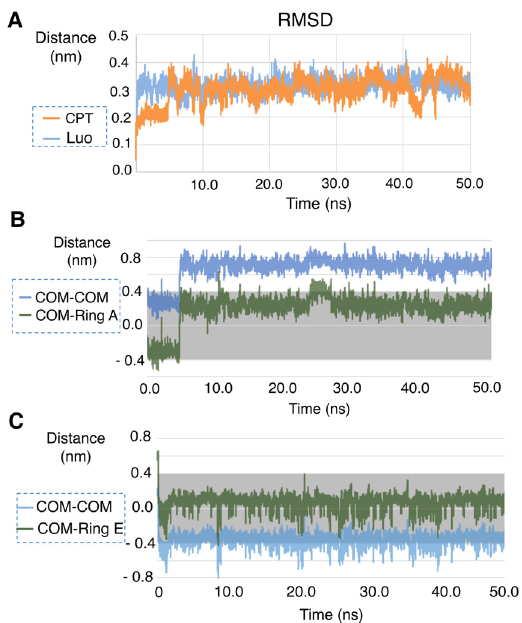
Figure 5. Molecular dynamics studies: ( A ) RMSD for the camptothecin- β -CD and luotonin A- β -CD complexes; ( B ) evolution of the distance between the center of mass (COM) of β -CD and the center of mass of camptothecin, and similar study of the center of ring A; ( C ) evolution of the distance be- tween the center of mass of β -CD and the center of mass of luotonin A, and similar study of the center of ring E.